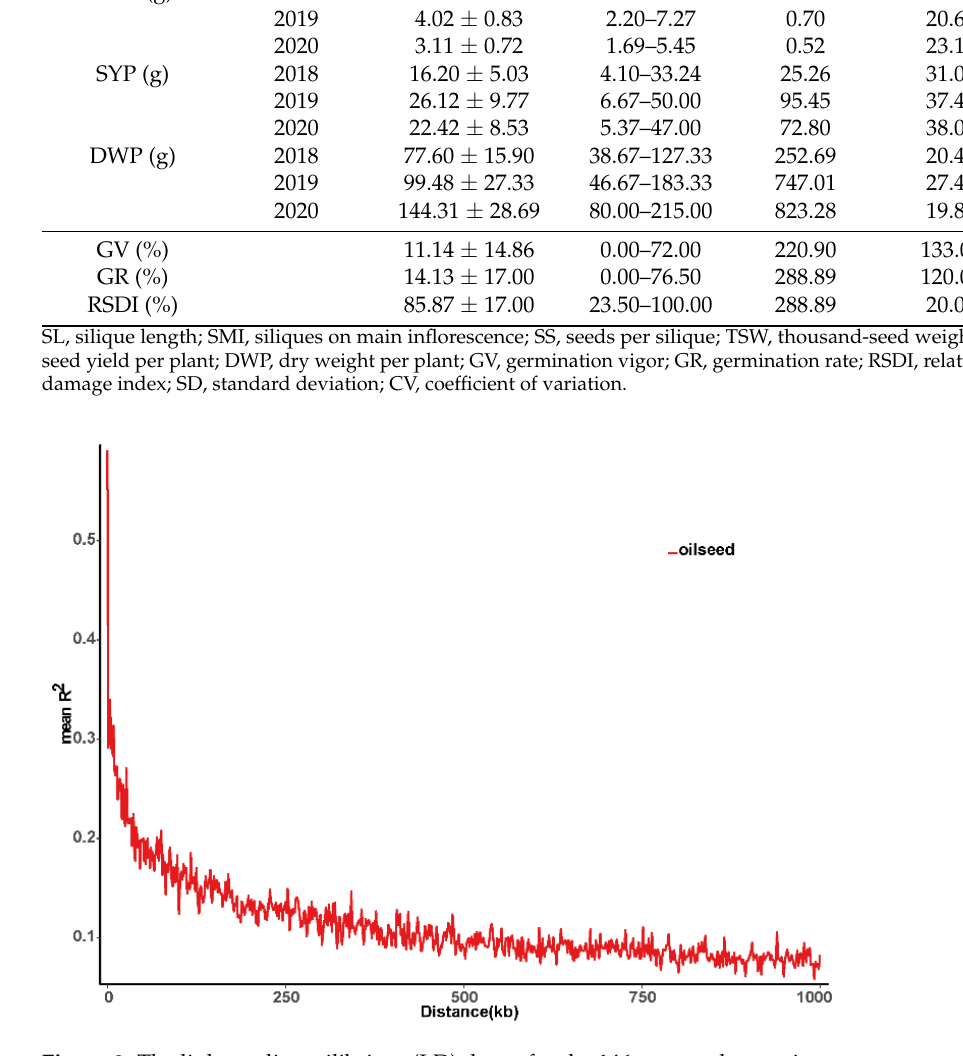
The population structure was analyzed using Admixture software, and the cross- validation (CV) error rate for K = 1–10 was examined. As shown in Figure 3A,B, when K = 3, the CV dropped to the lowest value, which indicated that the entire population could be divided into three subgroups. The phylogenetic tree analysis also showed that the 146 accessions could be assigned to three groups (Figure 3C). Furthermore, the genetic variance between accessions was conducted by PCA analysis. The first three components explained 7.02, 5.38, and 2.48% of the variance, respectively (Figure 3D). The kinship was evaluated using SPAGEDi software (Figure 3E). The results showed that 85.2% accessions had a genetic similarity coefficient lower than 0.05, indicating that the genetic relatedness among rapeseed individuals was